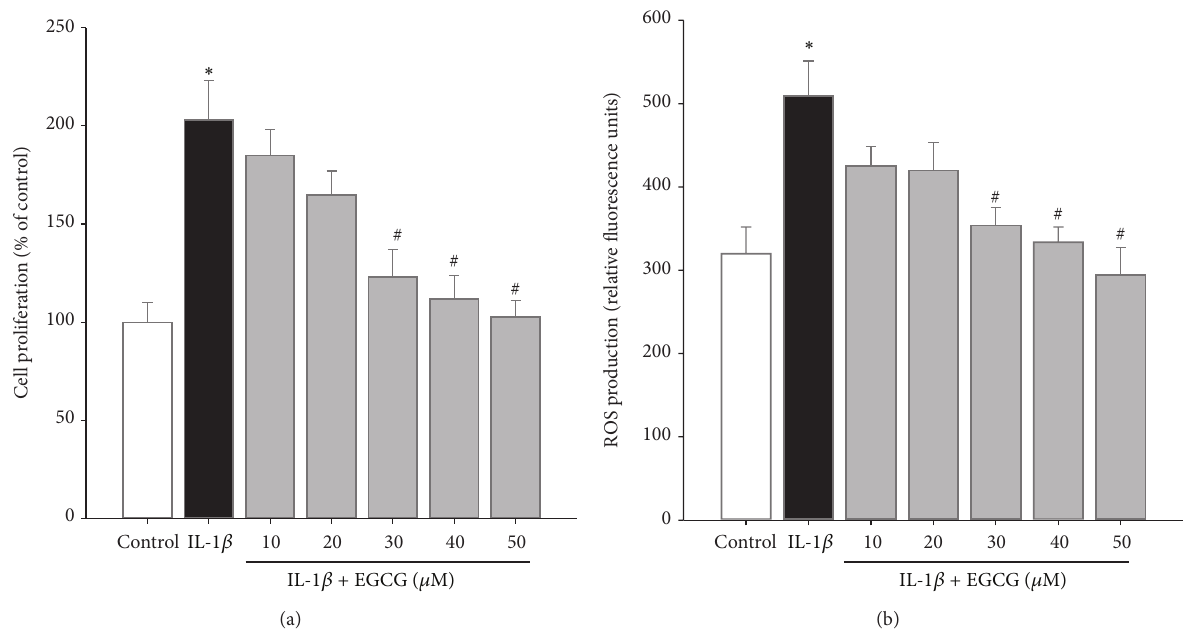
Figure 3: EGCG dose-dependently inhibits (a) cell proliferation and (b) ROS production in IL-1 𝛽 -treated HASMCs. Data are expressed as mean ± SD of three independent experiments. ∗ 𝑃 < 0.05 versus control group; # 𝑃 < 0.05 versus IL-1 𝛽 -treated group.